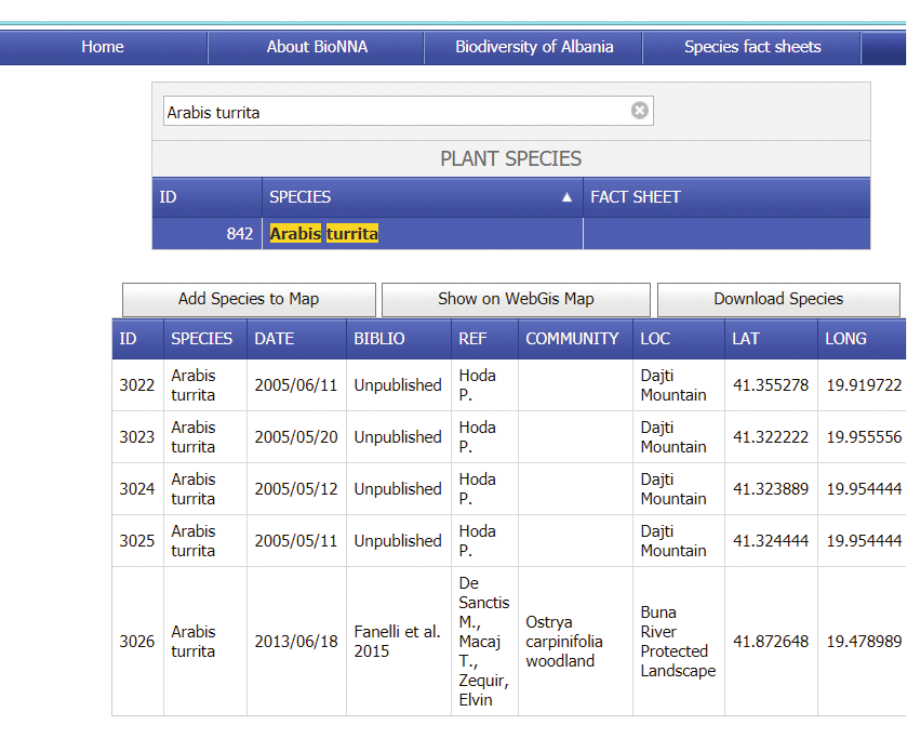
Figure 2. The BioNNA search interface.